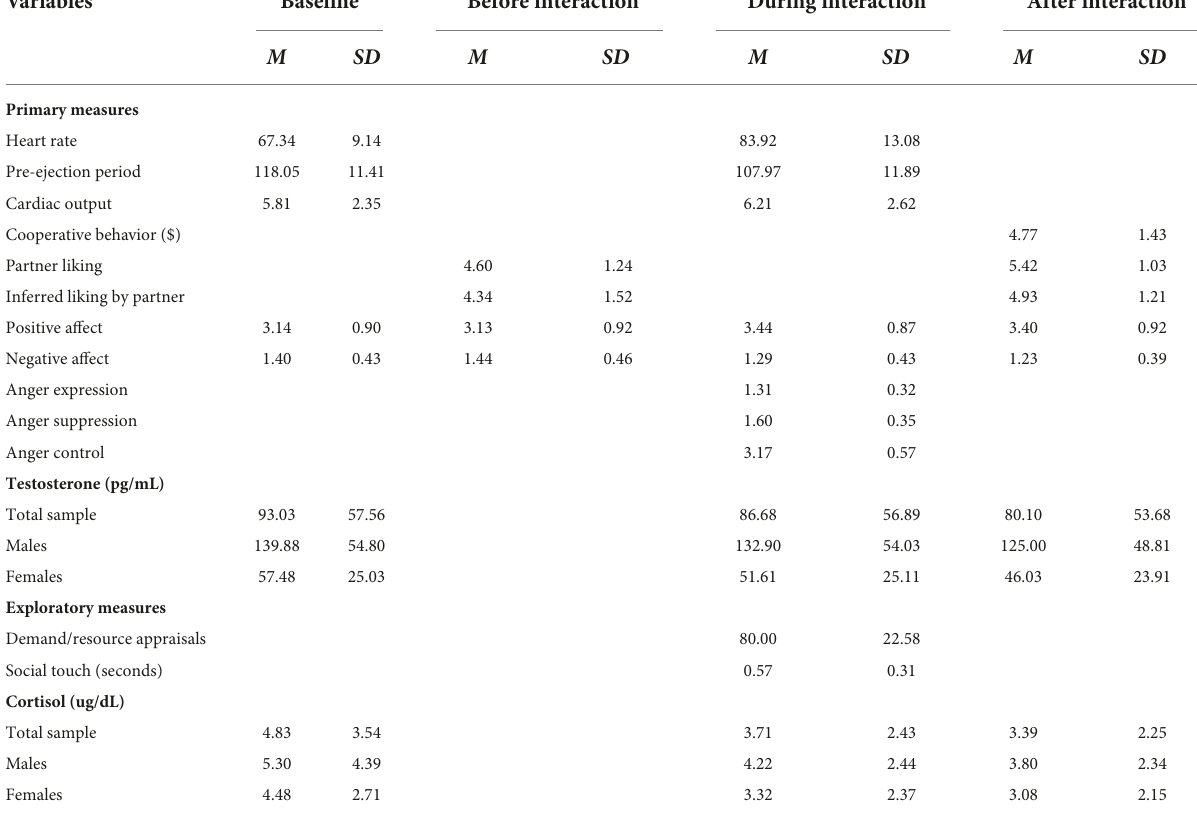
TABLE 1 Descriptive statistics of study variables assessed at four time points throughout the study.